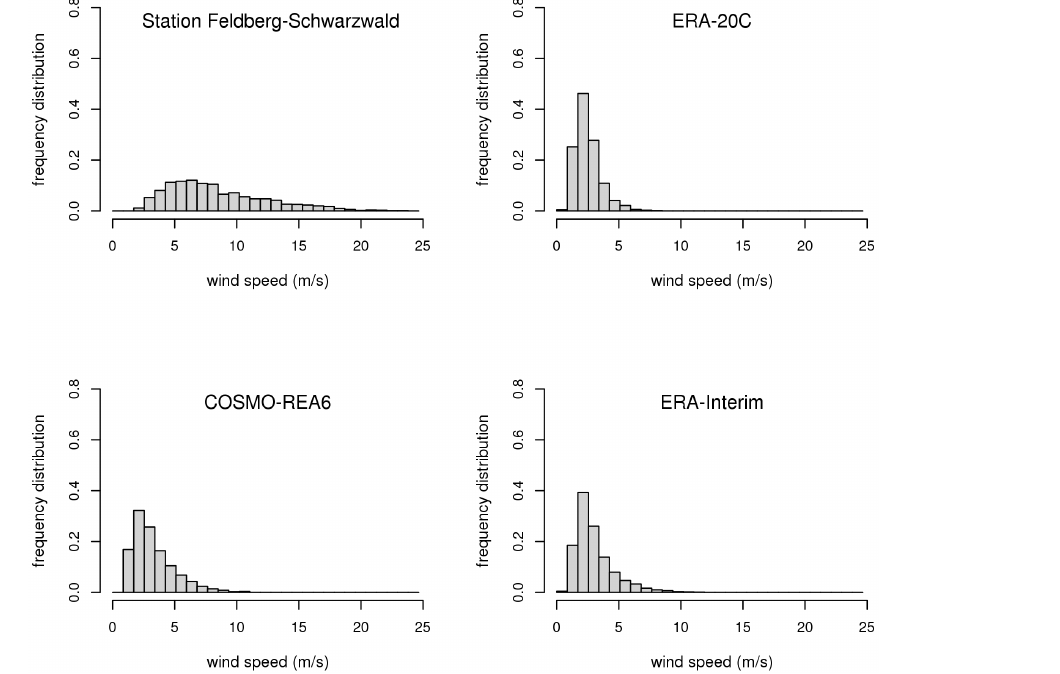
Figure 5. Frequency distribution of daily mean wind speeds in the period 2007 to 2010 for the station Feldberg-Schwarzwald (top left) and matching grid cells of ERA-20C (top right), COSMO-REA6 (bottom left), and ERA-Interim wind fields (bottom